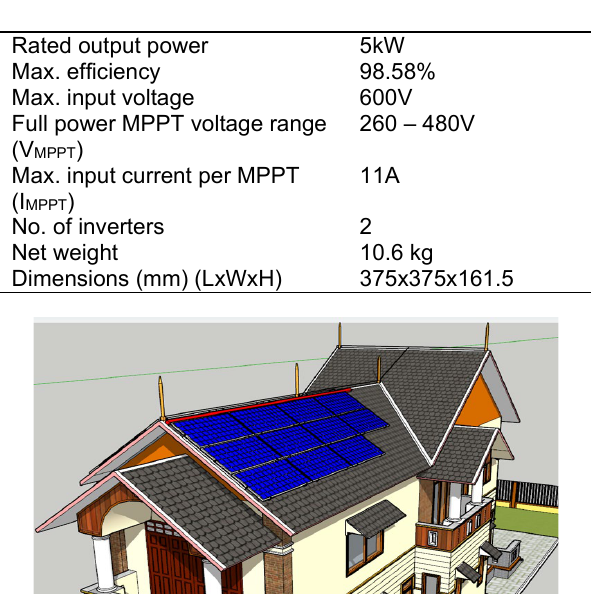
Figure 5. 3D house model in Sketchup